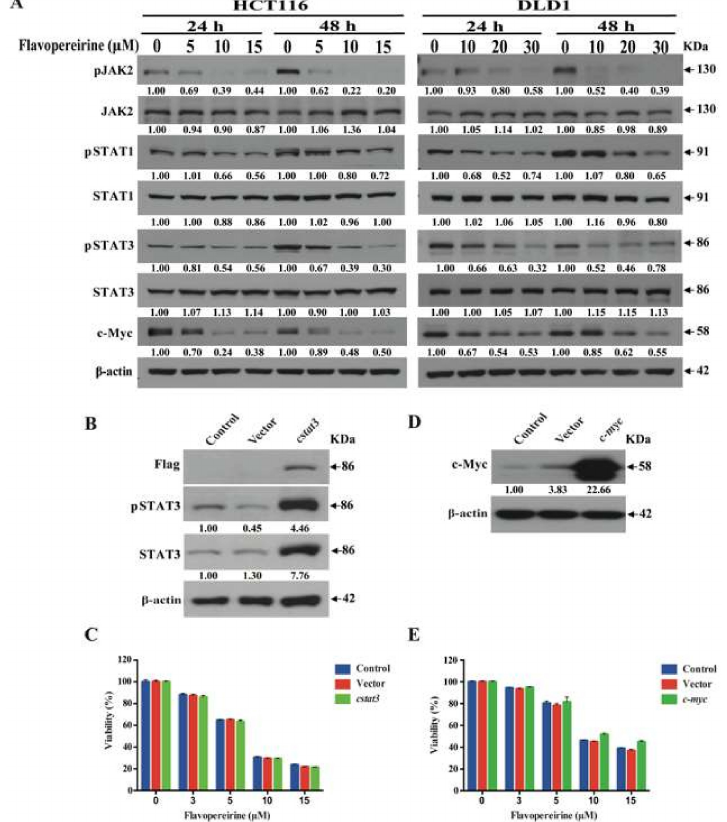
Figure 4. Flavopereirine non-dependently utilized STAT3 / c-Myc signaling to reduce CRC cell viability. ( A ) Phosphorylation of JAK2, STAT1 and STAT3 and expression of downstream c-Myc protein were suppressed in a dose-dependent manner after treatment with flavopereirine for 24 h and 48 h. ( B , D ) STAT3 and c-Myc proteins were strongly upregulated by introducing cstat3 and c-myc into CRC cells at 48 h. ( C , E ) The enforced expressions of STAT3 and c-Myc did not reverse flavopereirine-mediated viabilityreductioninCRCcells.